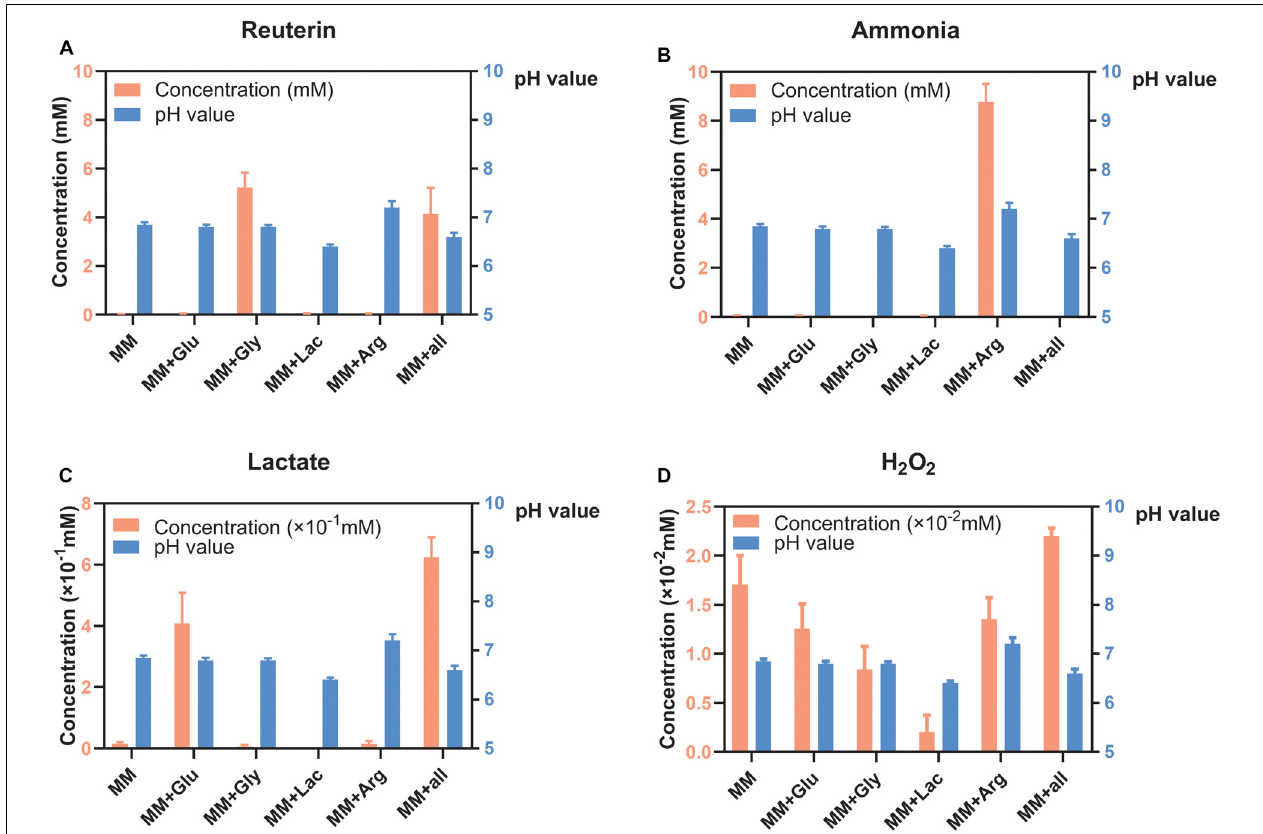
FIGURE 2 | Concentration of metabolites and pH of L. reuteri (means ± standard deviations, n = 3) in six different MM media; minimal medium (MM), MM with glucose (MM+Glu), MM with glycerol (MM+Gly), MM with Lactic acid (MM+Lac), MM with arginine (MM+Arg) and all-full medium (MM+all). The left Y axis showed the concentration and the right Y axis showed the pH value. (A) Reuterin was detected in both MM+Gly and MM+all. (B) Ammonia was only detected in MM+Arg. (C) Lactate was mainly produced in MM+Glu and MM+all. (D) H 2 O 2 was produced in all groups, the lowest being in MM+Lac.